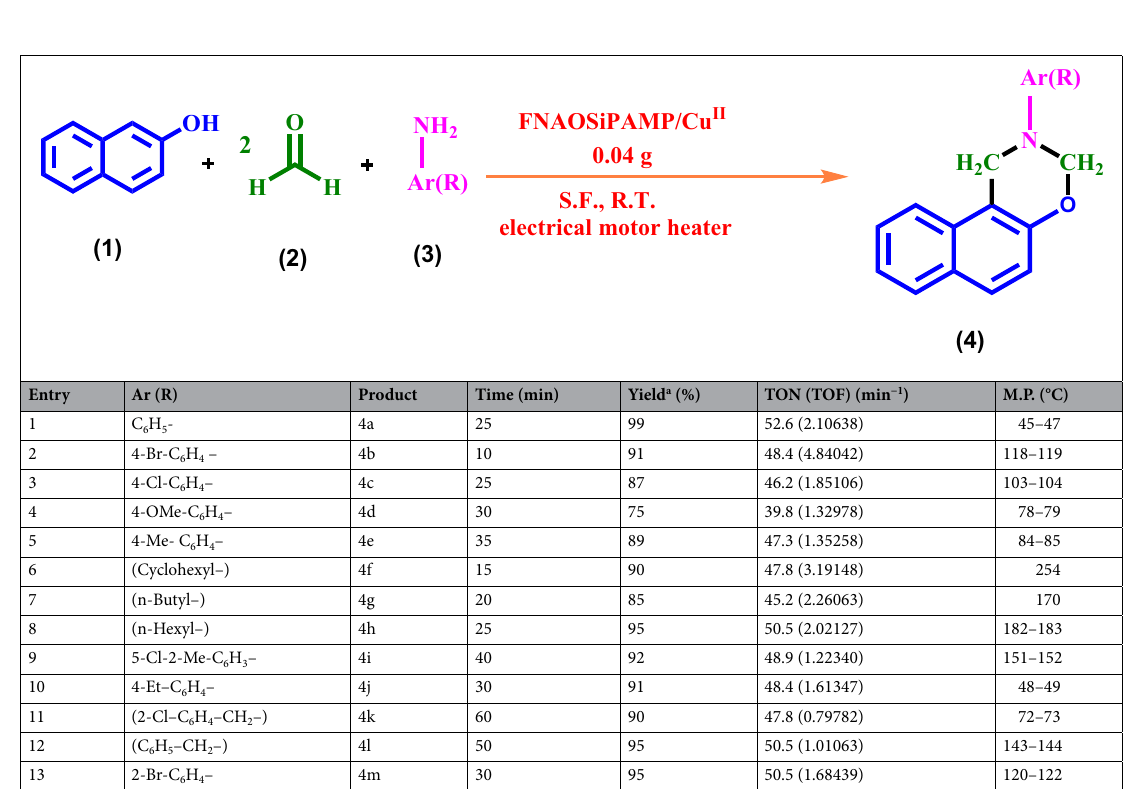
Table 2. Synthesis of naphtho[1,2- e ][1,3]oxazines derivatives 4a-m by using various aniline derivatives, formaldehyde and β-naphthol in the presence of FNAOSiPAMP/Cu II . The amount ratio of amine 1°, formaldehyde and β-naphthol is equal to 1:2:1. a Isolated